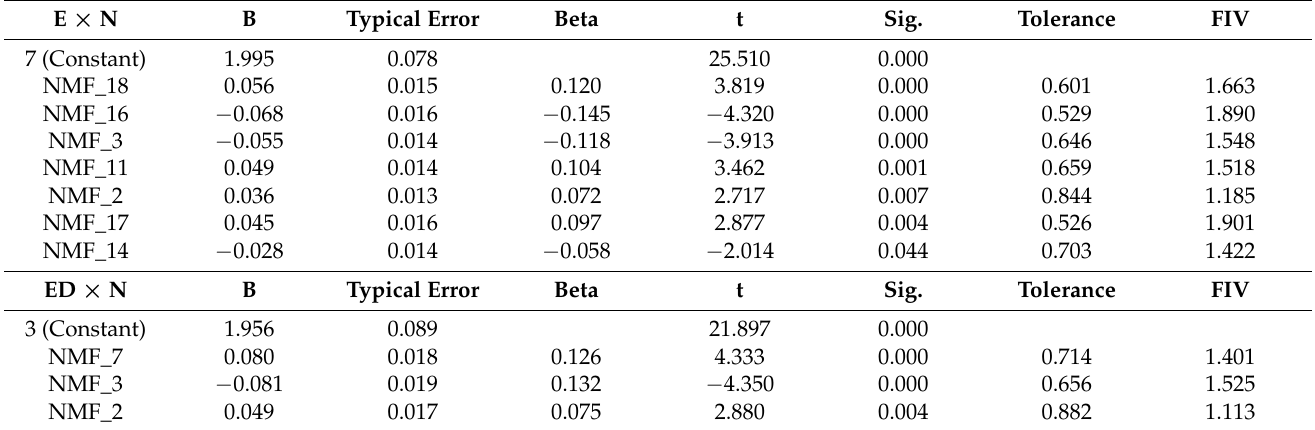
Table 4. Coefficients of the multiple linear regression